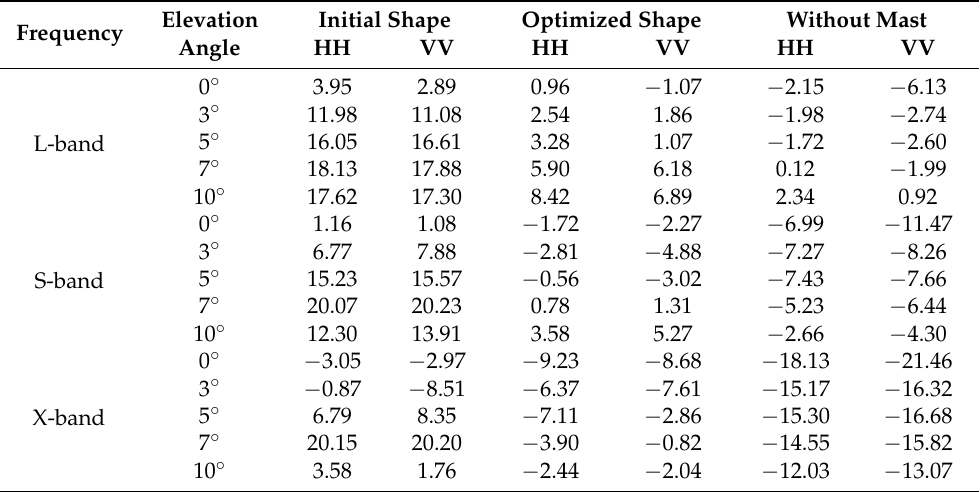
Table 3. Geometrical mean of a naval vessel equipped with the integrated mast. (Unit: dBsm).